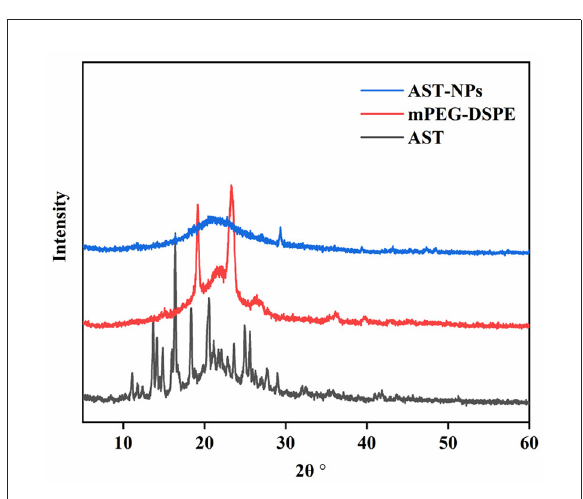
FIGURE3 XRD patterns of AST-NPs, mPEG-DSPE and free